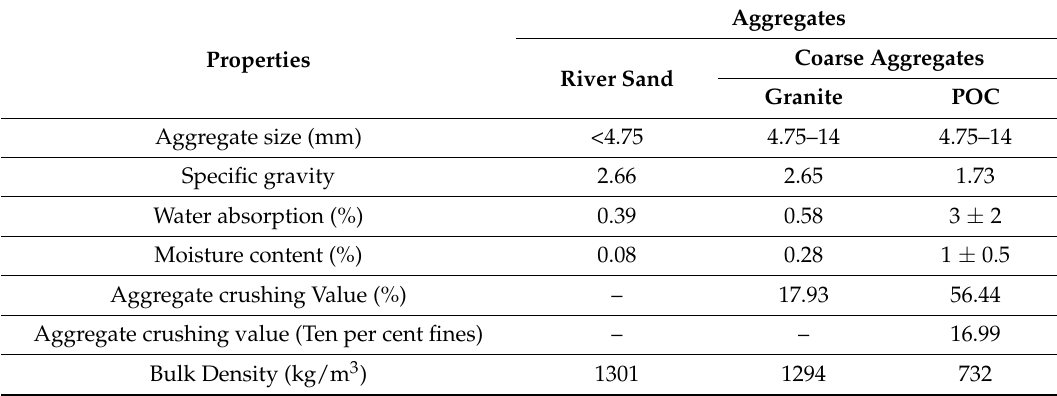
Figure 3. Coarse aggregate: ( a ) Granite; ( b ) Palm oil clinker (POC). Table 1. Physical characteristics of the aggregates.